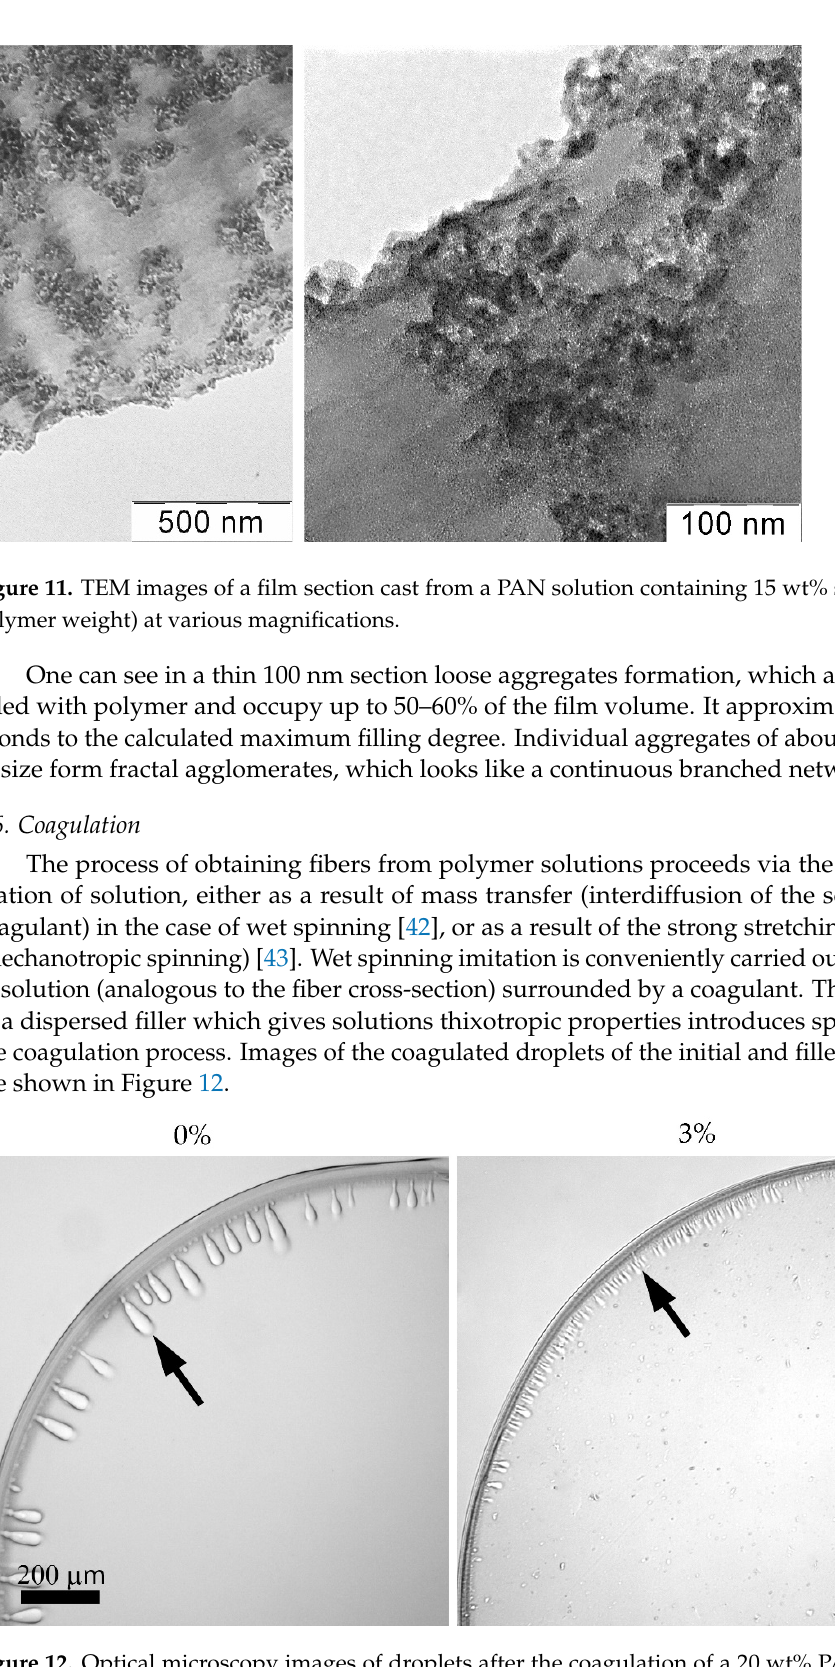
13 of 20 Figure 10. Dependence of the relative relaxation times on silica concentration at different frequency (indicated in plot). Silica concentration (c) is at the solution weight. For solid particles, the infinite cluster formation concentration ( φ m ) decreases with decreasing particle size and can be estimated from Equation [41]: 1 𝜑 (cid:3040) = 0.06 (cid:3493)𝑑 (cid:3032)(cid:3044) (cid:3119) + 1, (2) where d eq is the equivalent particle diameter. Based on the size of the individual particles of 20 nm, the calculated concentration of the percolation threshold for silica is ~4%, (or 6.7% for 80 nm aggregates), which corre- sponds to the strong increase in the relaxation time and the appearance of thixotropy for